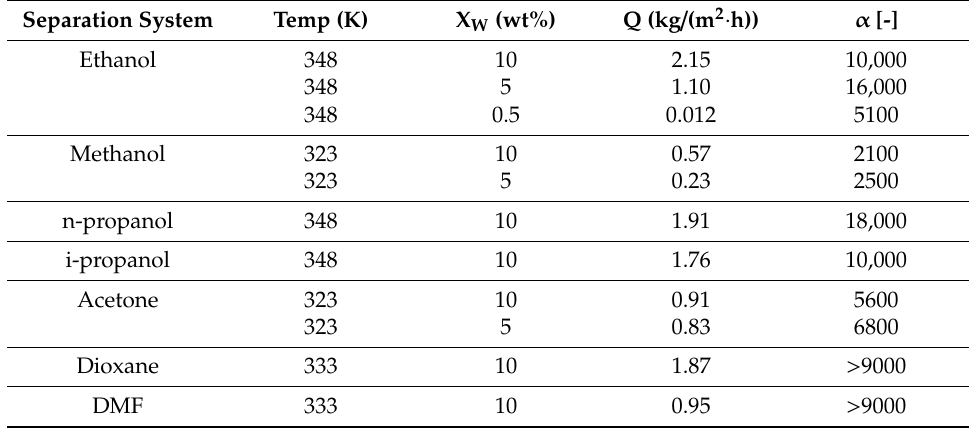
Table 1. Pervaporation (PV) performance of the zeolite NaA membranes toward water / organic liquid systems; Reproduced with permission from